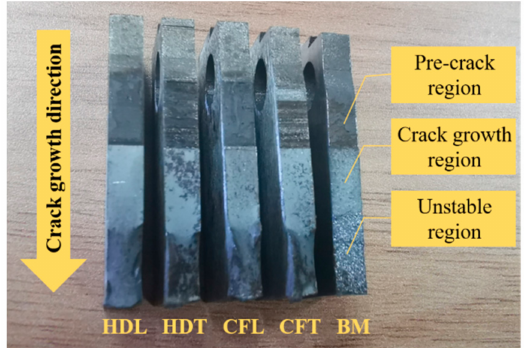
Figure 9. Macroscopic fracture morphology of five